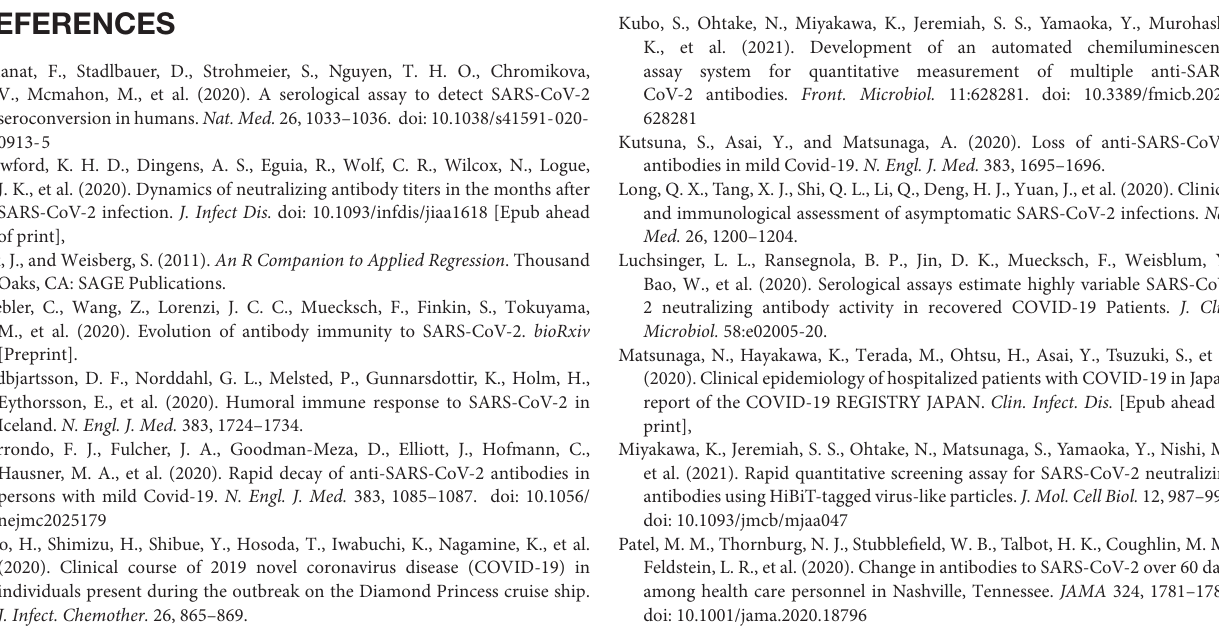
Supplementary Figure 1 | Scatterplot of neutralizing titers (NT 50 ) calculated from the neutralization analysis using the SARS-CoV-2 pseudovirus against NT 50 calculated from the assay using the authentic SARS-CoV-2 in a validation study (Spearman’s correlation coefficients = 0.80). Supplementary Figure 2 | Number of participants by date of test for COVID-19 diagnosis. Histogram for number of participants by date of test for COVID-19 diagnosis is shown. Supplementary Figure 3 | Scatterplot of NT 50 against days from the first positive test. Scatterplot of neutralizing titers against days from the first positive test for COVID-19 diagnosis is shown. NT 50 : neutralizing